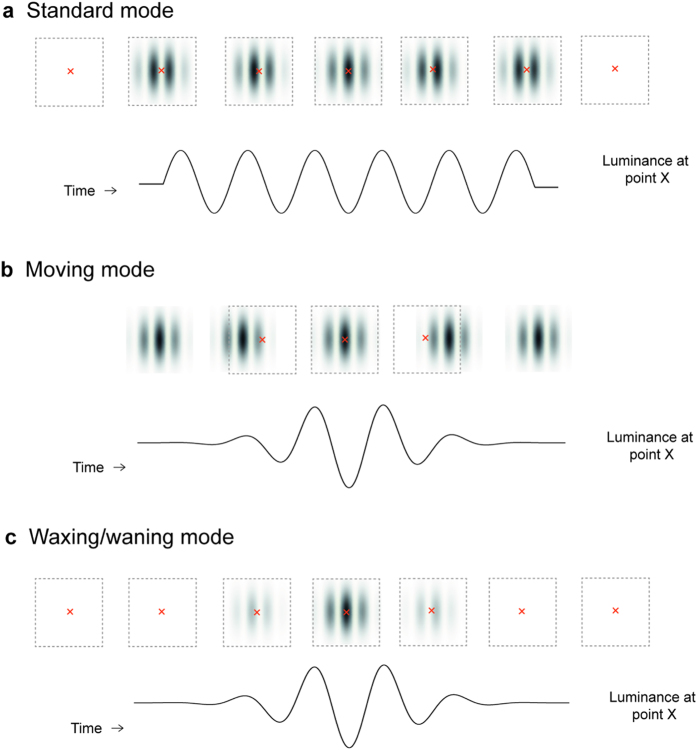
The three modes of stimulus presentation.For each panel, the top row illustrates the spatial relationship between the Gabor patch and the receptive field (indicated by the dotted squares) at several time points. The bottom row represents the evolution of stimulus luminance at the centre of the receptive field (marked by a red cross). There was a 1 s stationary period for Gabor patches in the standard and the moving mode (see Methods), which is not shown in this figure for simplicity.